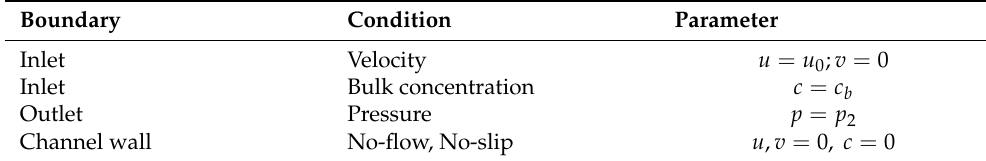
Table 1. Summary of boundary